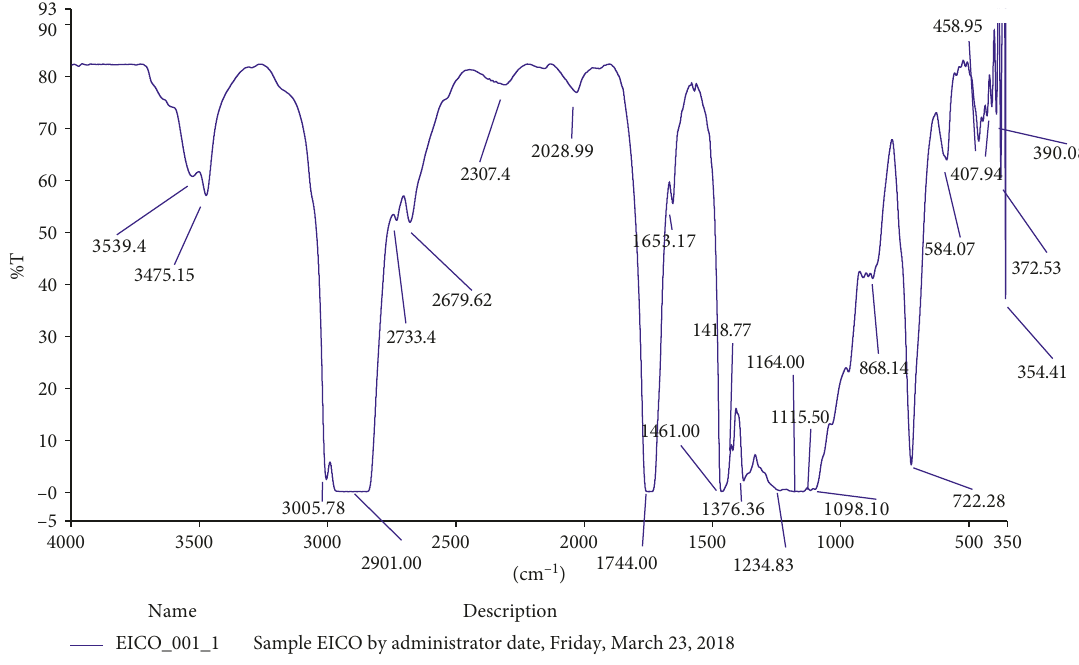
Figure 8: EICO FTIR